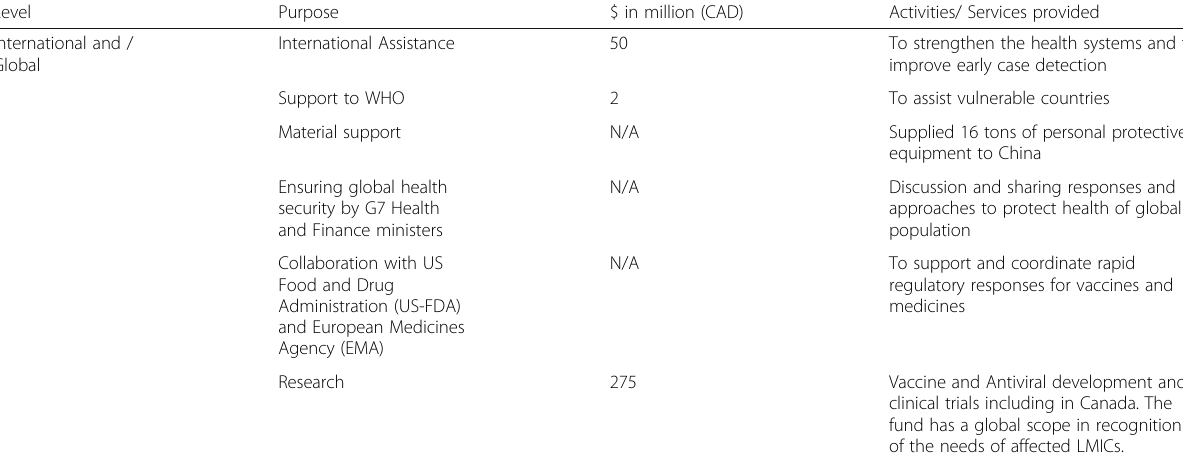
Table 1 Canada ’ s financial commitments and assistance in response to the COVID-19 epidemic